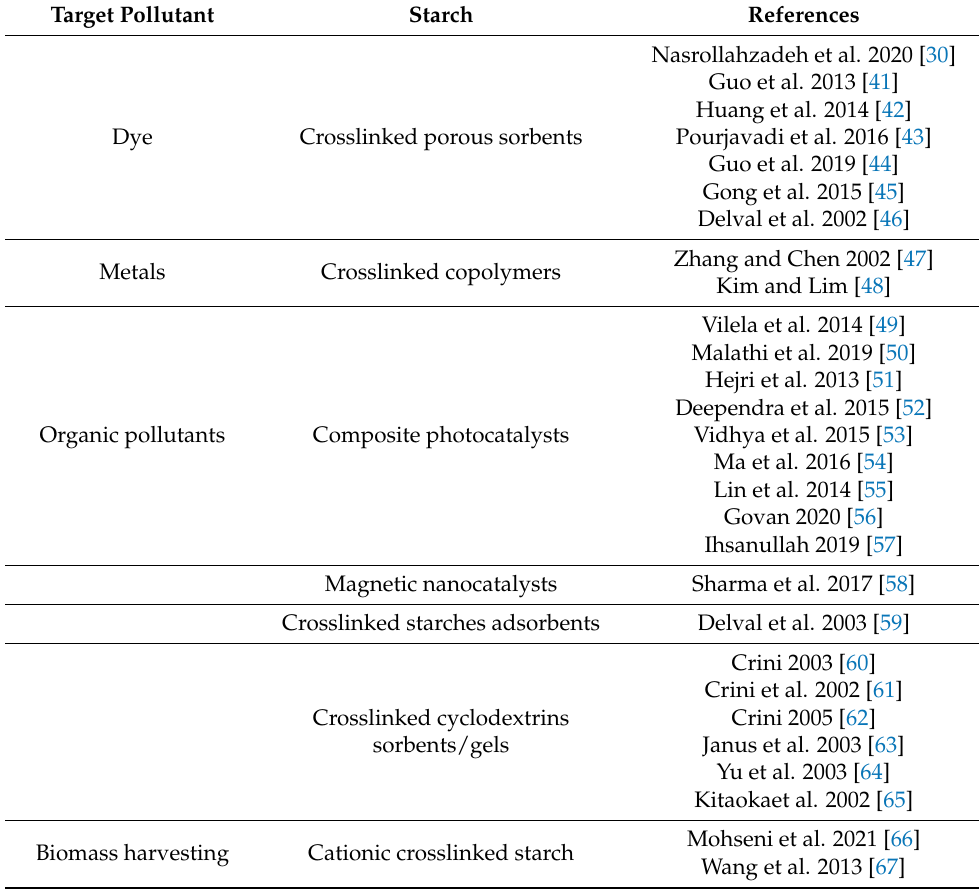
Table 2. Starch potential in pollutant